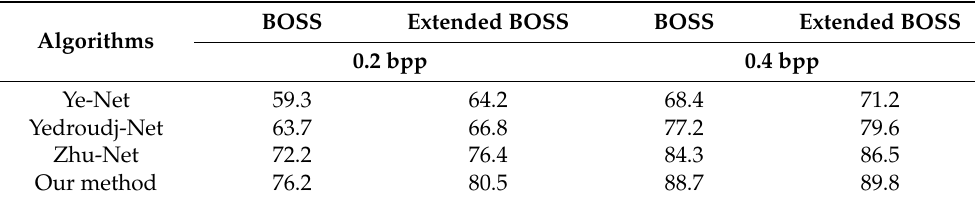
Table 4. Accuracy (%) of Ye-Net, Yedroudj-Net, Zhu-Net, and our proposed method for S-UNIWARD at 0.2 bpp and 0.4 bpp on the original BOSS dataset and the extended BOSS dataset. BOSS Extended BOSS BOSS Extended BOSS Algorithms 0.2 bpp 0.4